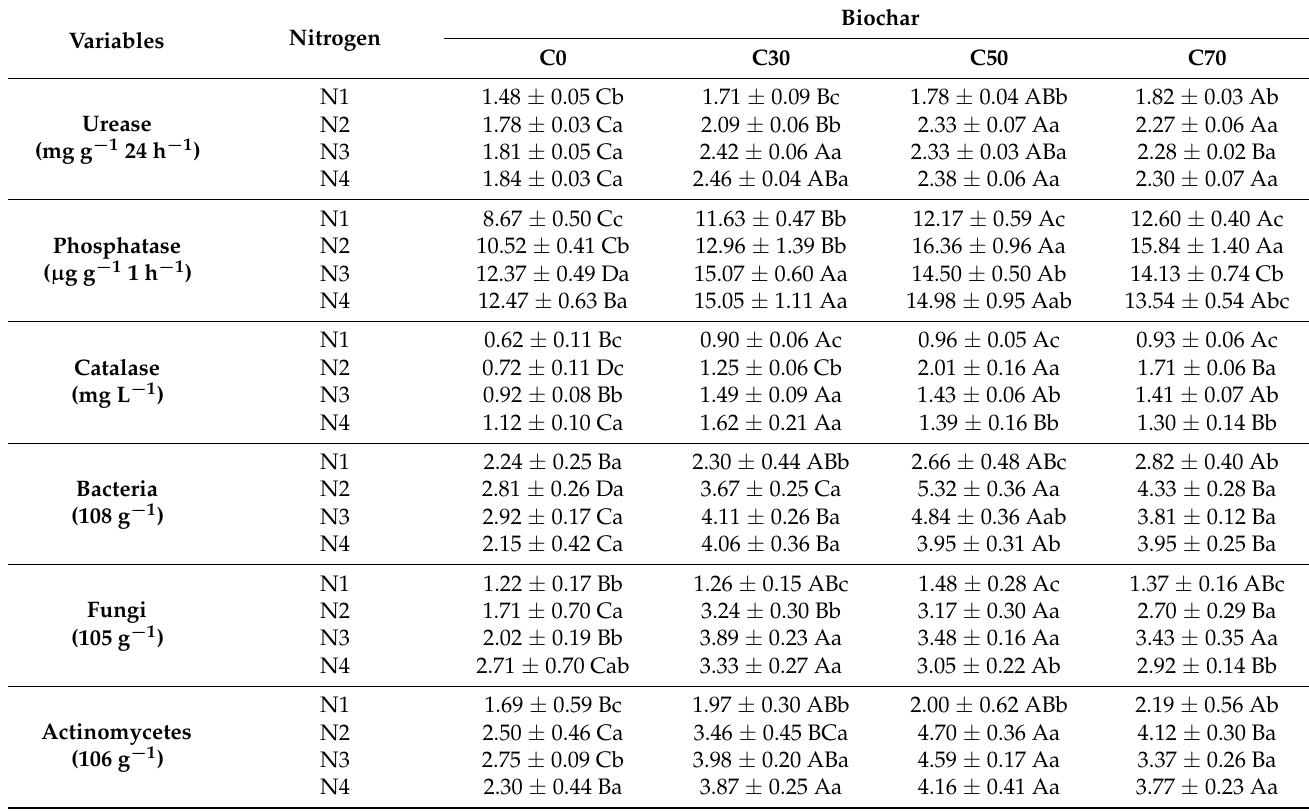
Table 2. Descriptive statistics of urease, phosphatase, catalase, bacteria, fungi, and actinomycetes, as affected by N (N1, N2, N3, and N4) and biochar (C0, C30, C50, and C70); each value is the mean value of three replicates ± standard